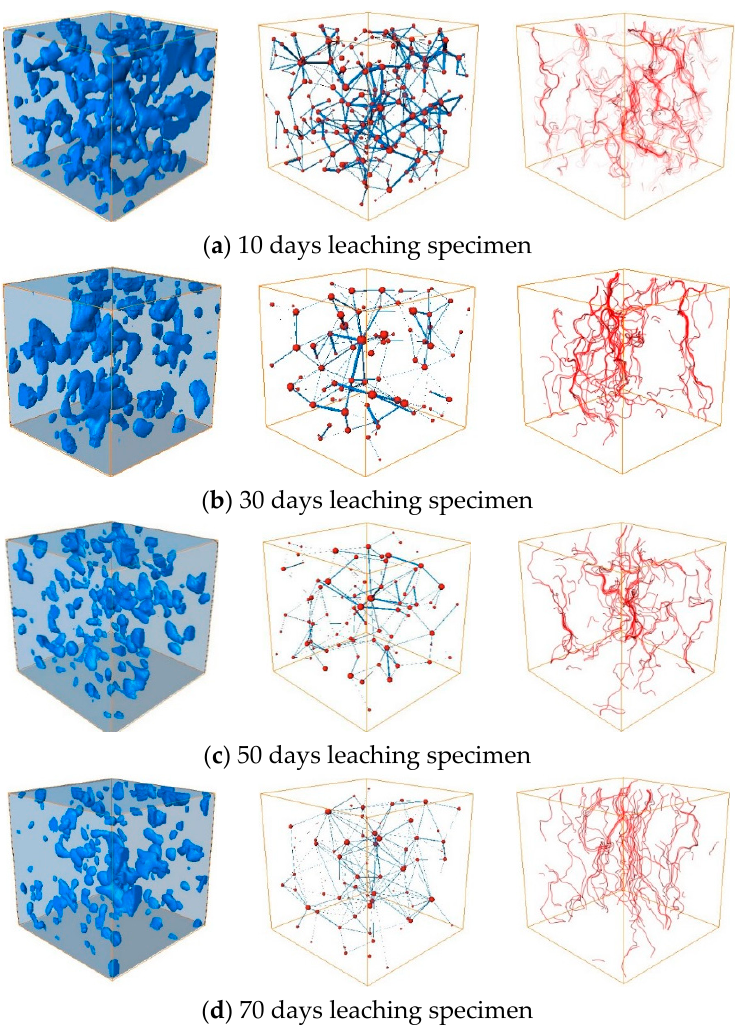
Figure 11. Three-dimensionally reconstructed visualised pores, pore network models, and seepage flow channel simulations.